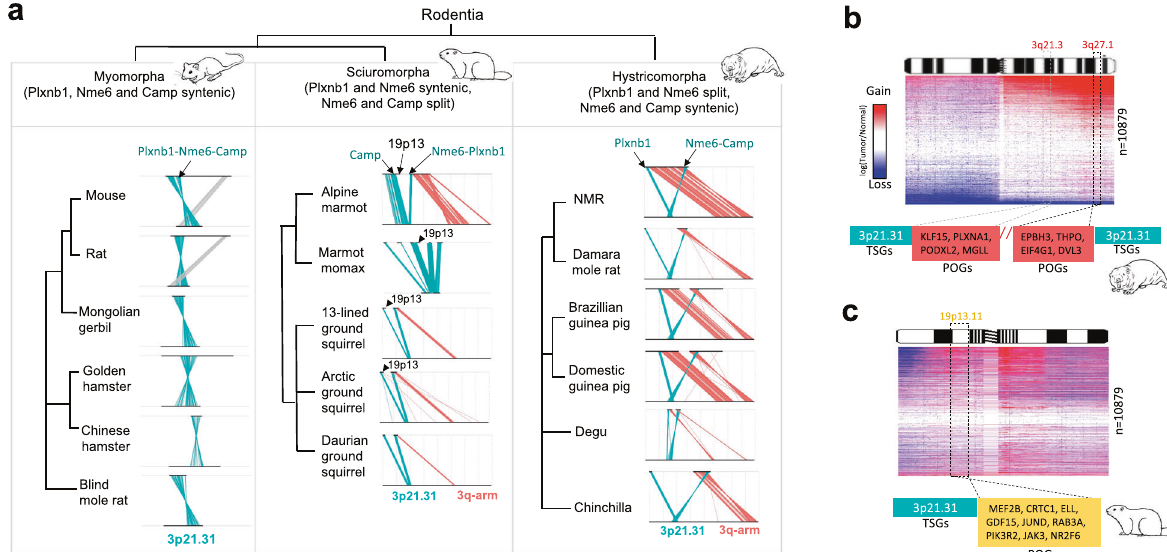
Fig. 2 Synteny status of 3p21.31 in major rodent clades. a Orthologous genomic position of human 3p21.31 genes in myomorphs, sciuromorphs, and hystricomorphs. The positions of PLXNB1, NME6 and CAMP genes are highlighted. PLXNB1-NME6 breakage marks the 3p21.31 split in hystricomorphs and NME6-CAMP breakage marks the split in sciuromorphs. b , c Gain of proximities between TSGs from 3p21.31 and the POGs from 3q21.3/3q27.1 in NMR ( b ), and from 19p13.21 in alpine marmot ( c ). Heatmaps represent relative gain and loss of CNVs in the PAN-Cancer cohort normalised to control